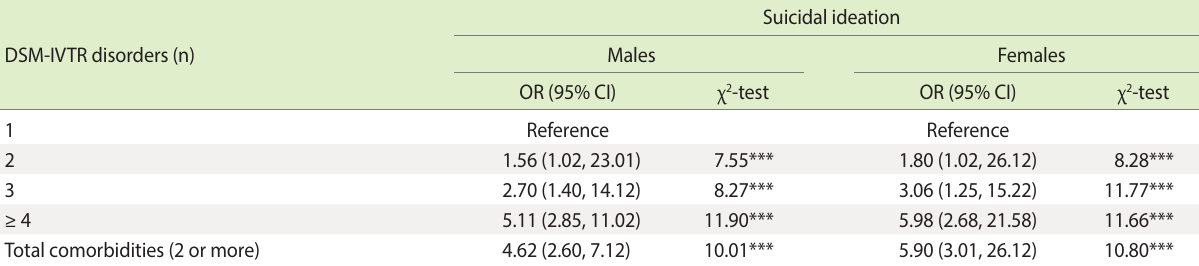
Table 4. Association between suicidal ideations and comorbidities of DSM-IVTR mental disorders by